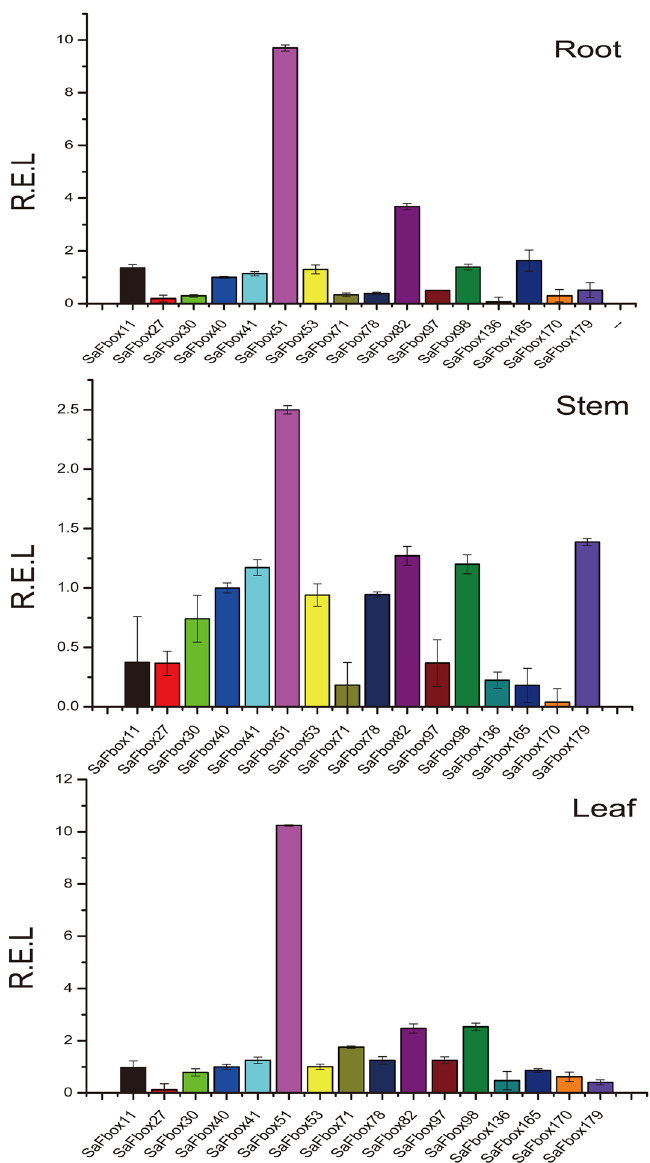
Figure 8. Expression profiles of 16 hub genes at different tissues under normal growth condition. ( A ) Root; ( B ) Stem; ( C ) Leaf. The gene expression levels relative to SaFbox40 were shown. Bars indicate means ± standard deviations (SDs) of at least three independent biological